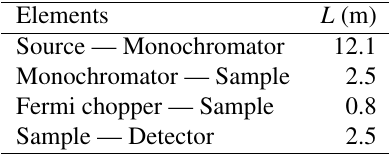
Table 1. Distances L on Panther. The source is taken as the nose (entrance) of the beam tube inside the heavy-water